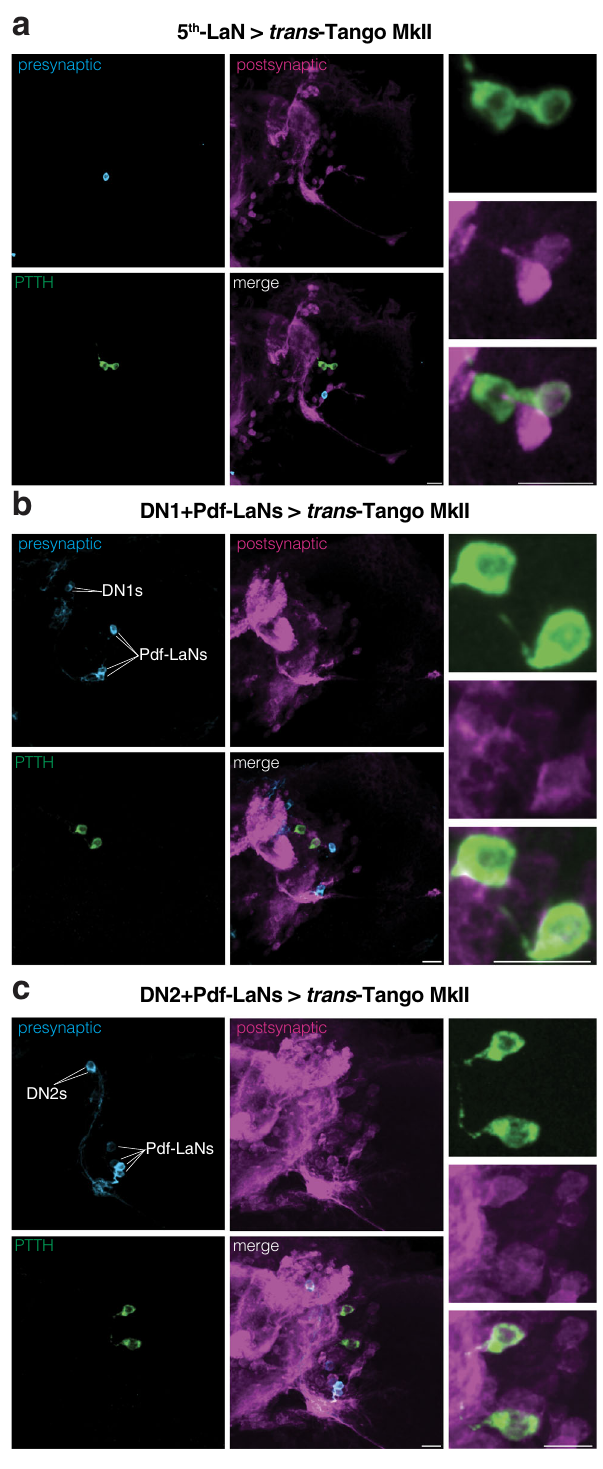
Fig. 2 | PTTH neurons receive direct input from 5th-LaN, DN1 and DN2 clock neurons.a OnlyoneofthePTTHneuronsreceivesinputfromthe5th-LaN. b , c Both PTTH neurons arepostsynaptic to DN1s ( b ) and DN2s ( c ). Inall panels, presynaptic GFP (cyan), postsynaptic mtdTomato-HA (magenta) and PTTH (green) are shown. Scale bars, 10 μ